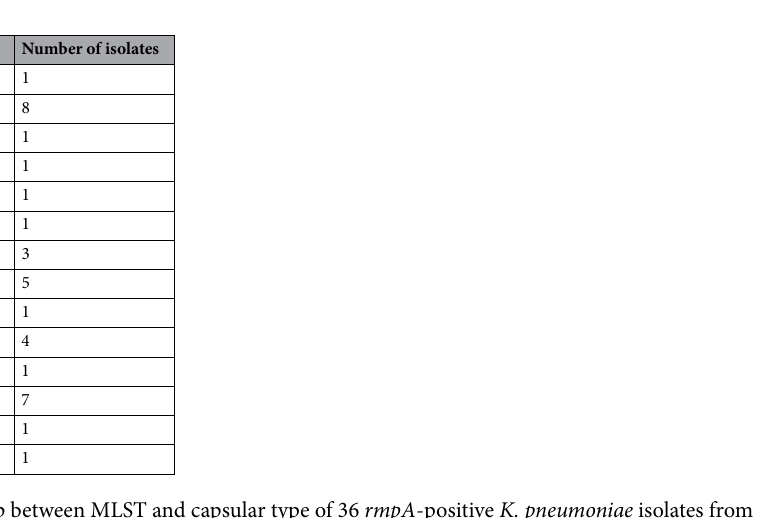
Table 3. Relationship between MLST and capsular type of 36 rmpA -positive K. pneumoniae isolates from patients with bloodstream infections.